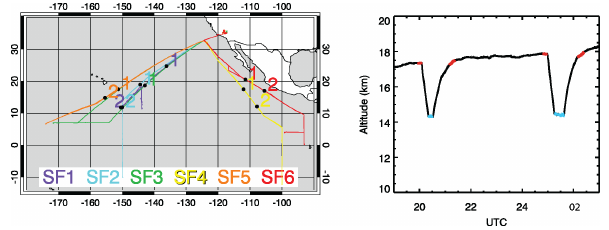
Figure 3. On the left is a map of the 2013 ATTREX flight lines. The black dots show the position of the vertical profiles used in this study. The numbers correspond to the first or second profile in that flight. Plotted on the right panel are examples of the profiles from the SF1. The SSFR transmittances are created using ratios of data averaged from right before and after the profile (red) and during level flight at the lowest altitude (blue).